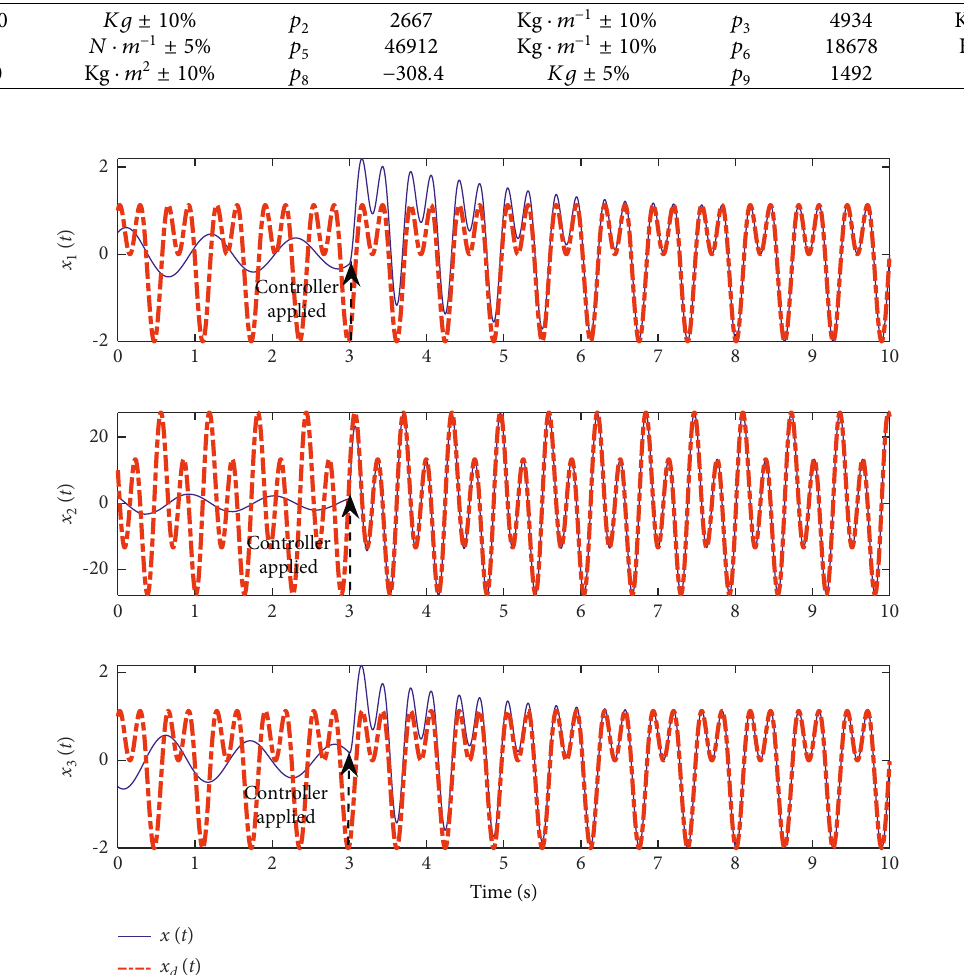
Figure 2: Time responses of x